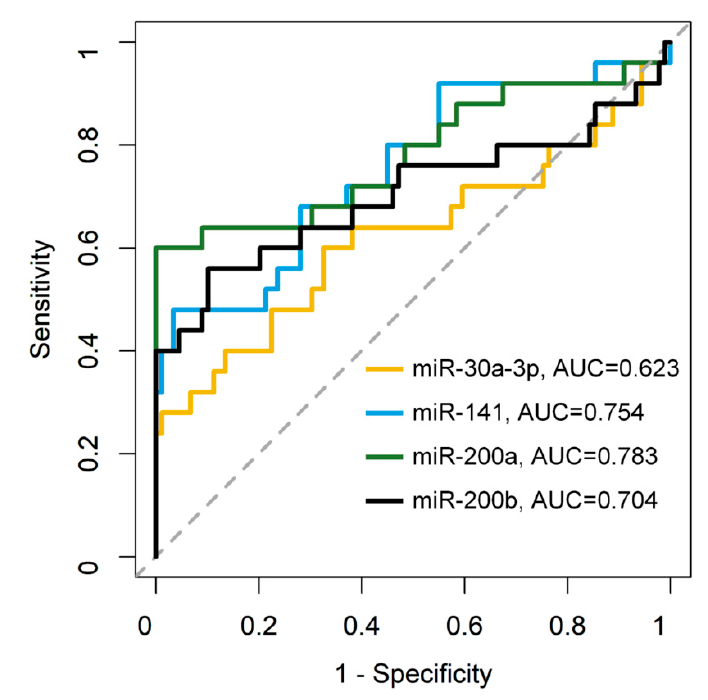
Figure 3. AUC analysis of miR-30a-3p, miR-141, miR-200a, and miR-200b. Table 1. Discriminative ability of various variables and panels for distinguishing patients whose SH/CH-nonA would subsequently progress to EC from those whose would not. Variables Sensitivity Specificity